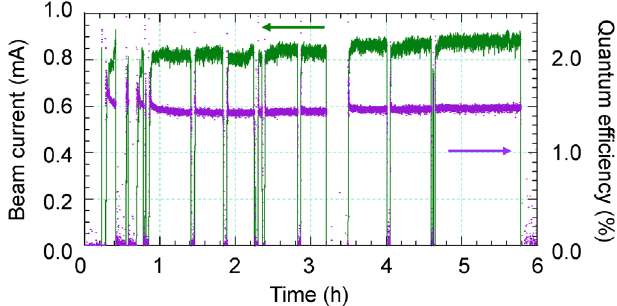
FIG. 4. Operational status of the gun during > 0 . 8 mA beam generation. The green and purple curves show the beam dump current and quantum efficiency of the GaAs photocathode, respectively, as a function of time.